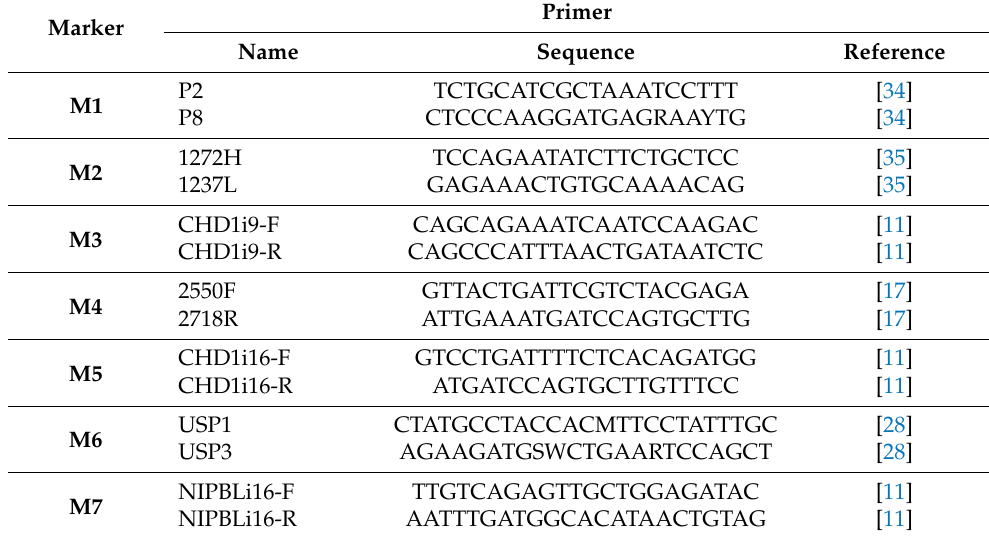
Table 2. PCR primers used in this